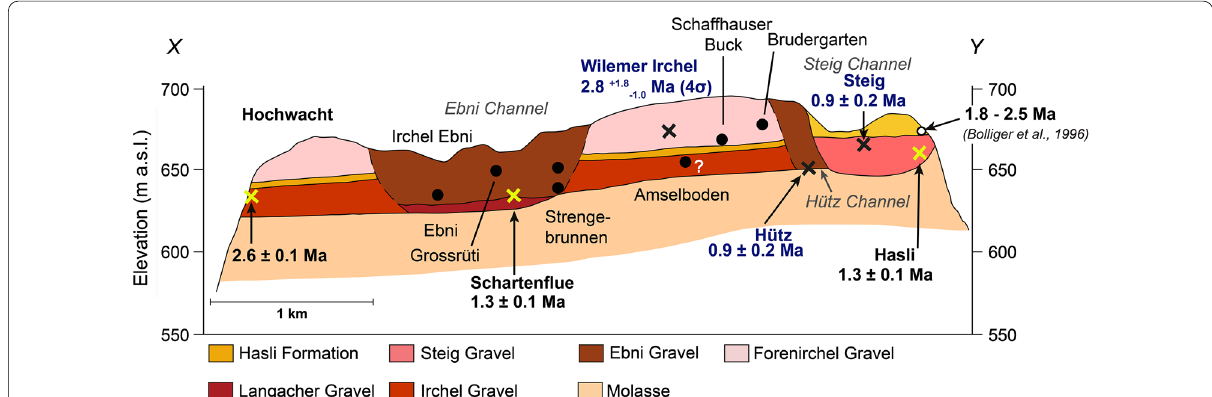
Fig. 15 Cross-section X–Y showing the reconstructed stratigraphy based on the existing and new established cosmogenic nuclide chronology as well as on the clast petrography (modified after Graf, 1993). For the position of the cross-section, please refer to Fig. 2